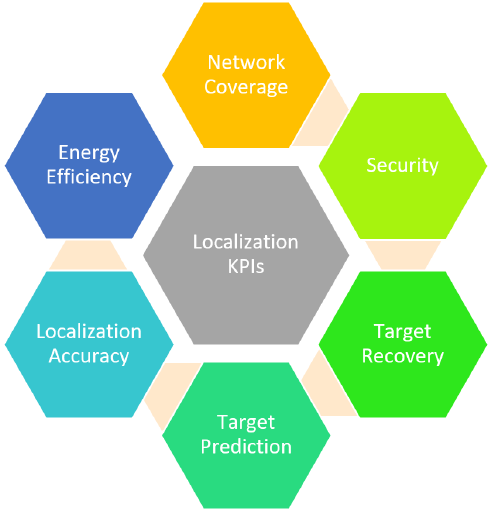
Figure 2. Parameter affecting the performance of localization.